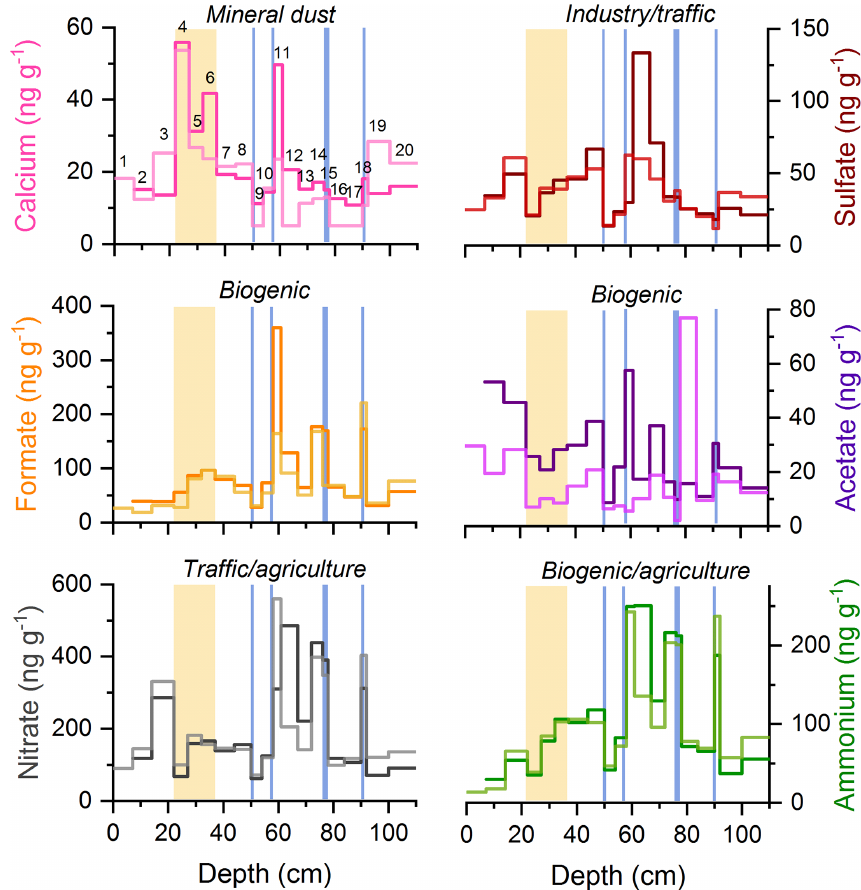
Figure 3. Ionic records from the Jungfraujoch snow pit with the two sets of replicates (darker and lighter lines). The orange bar indicates the depth at which rBC and microscopic charcoal peaks are observed. Blue bars represent ice layers. Sample numbers are specified for calcium and are similar for the other ions. Potential sources are indicated above each